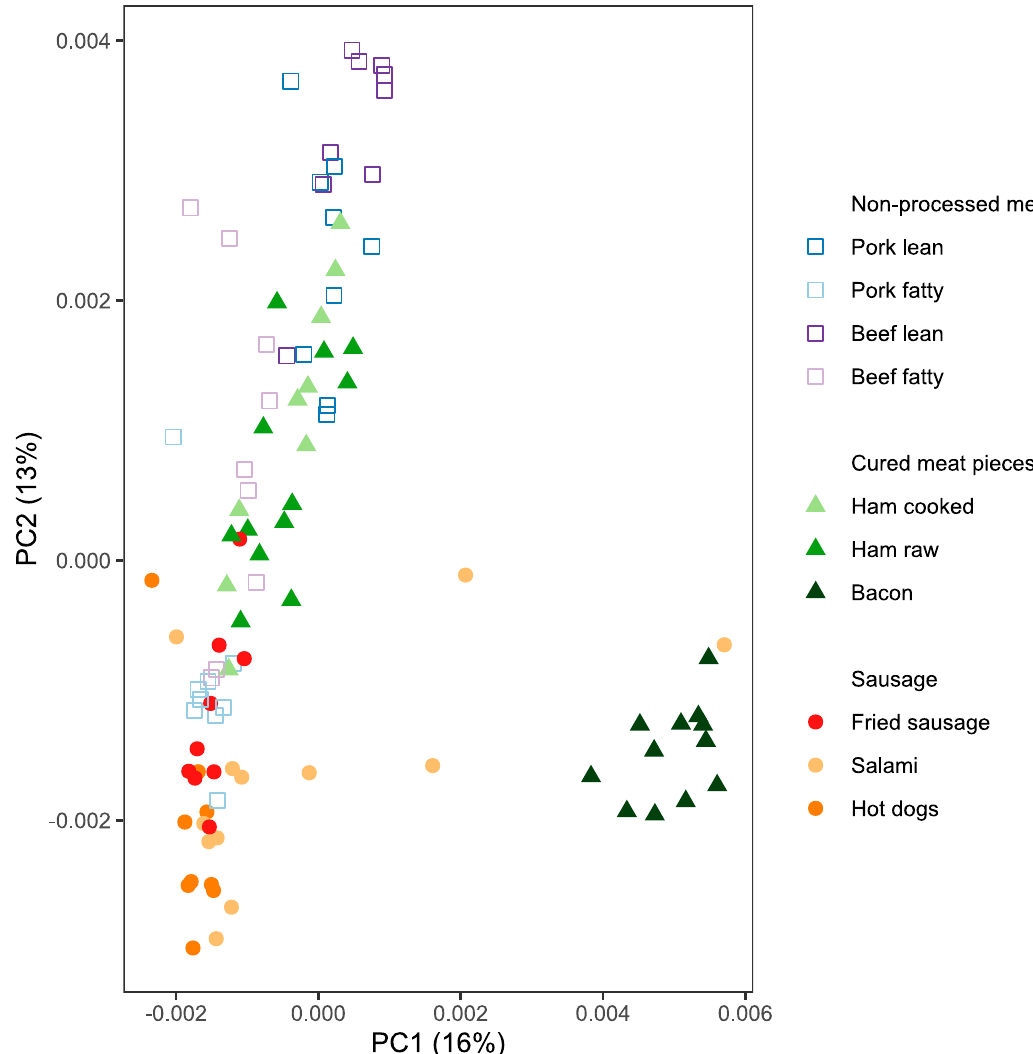
Figure 1. Principal component analysis of 5503 metabolite features detected in meat in vitro digests. Thirty-three meat products were digested in triplicate and the bioavailable fractions were analyzed by untargeted UHPLC–HRMS-based metabolomics. The figure shows the scores plot of the first and the second principal component which represent 16% and 13% of the metabolites’ variability, respectively. Metabolite intensities were normalized by total ion count of each sample to account for differences in water content between products.